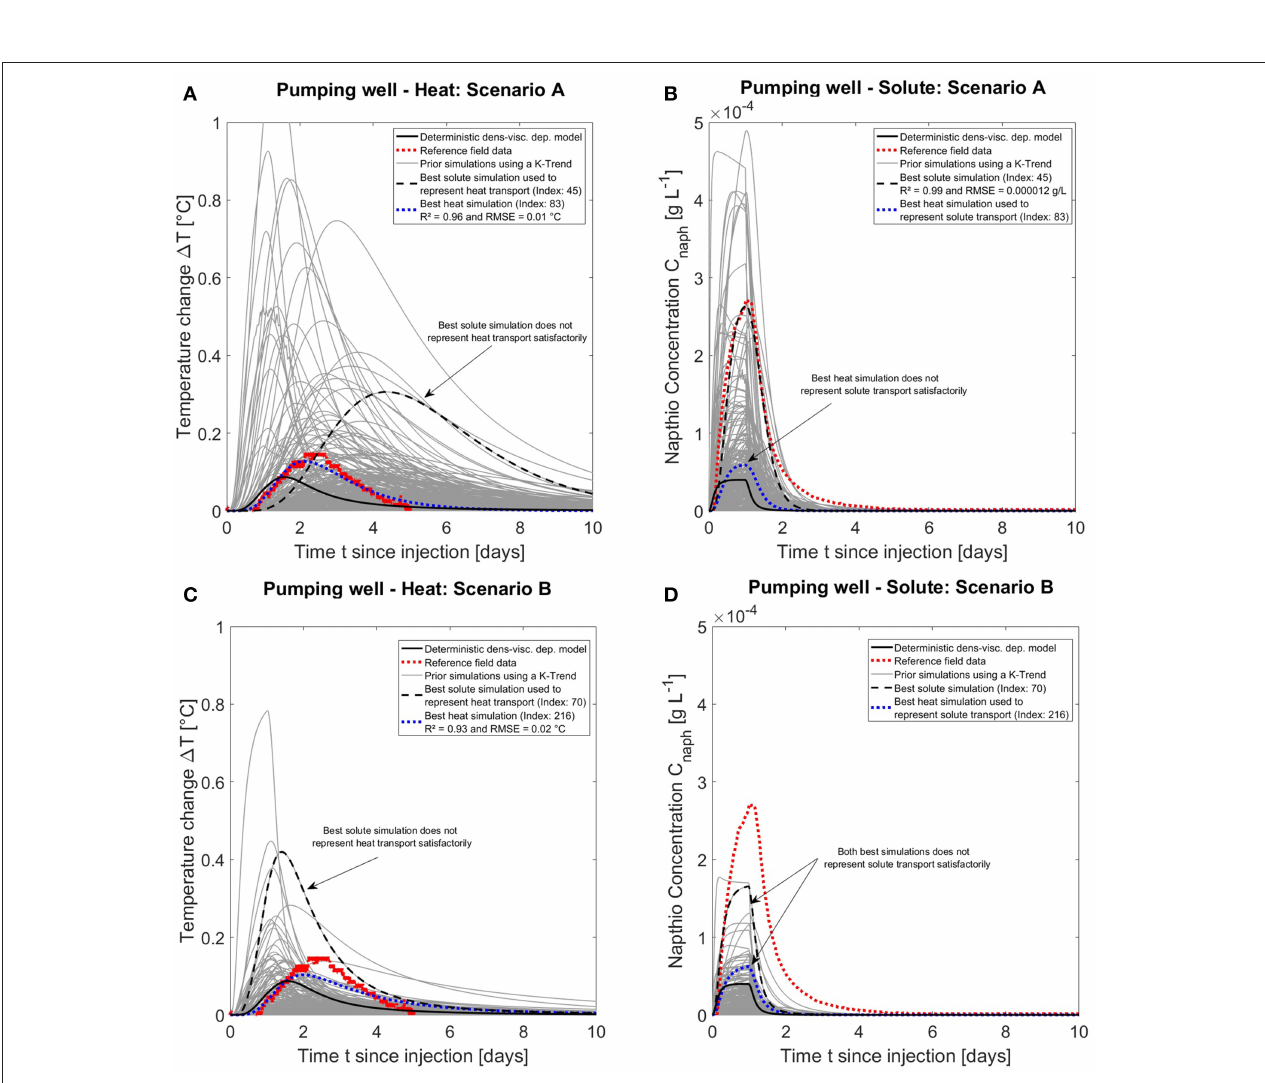
Frontiers in Earth Science | www.frontiersin.org